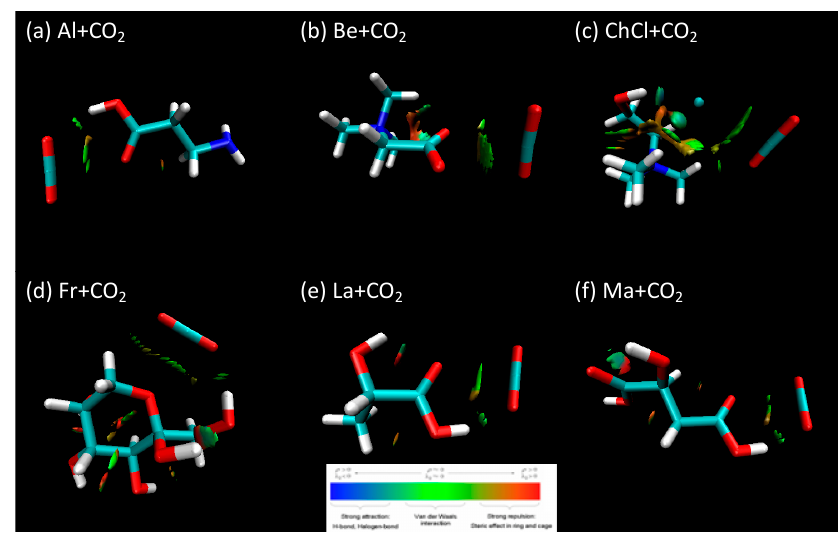
Figure 3. ReducedDensityGradient(RDG)isosurfacesforHBA + CO 2 andHBD + CO 2 cases. ( a )Al + CO 2 , ( b ) Be + CO 2 , ( c ) ChCl + CO 2 , ( d ) Fr + CO 2 , ( e ) La + CO 2 , ( f ) Ma + CO 2 .